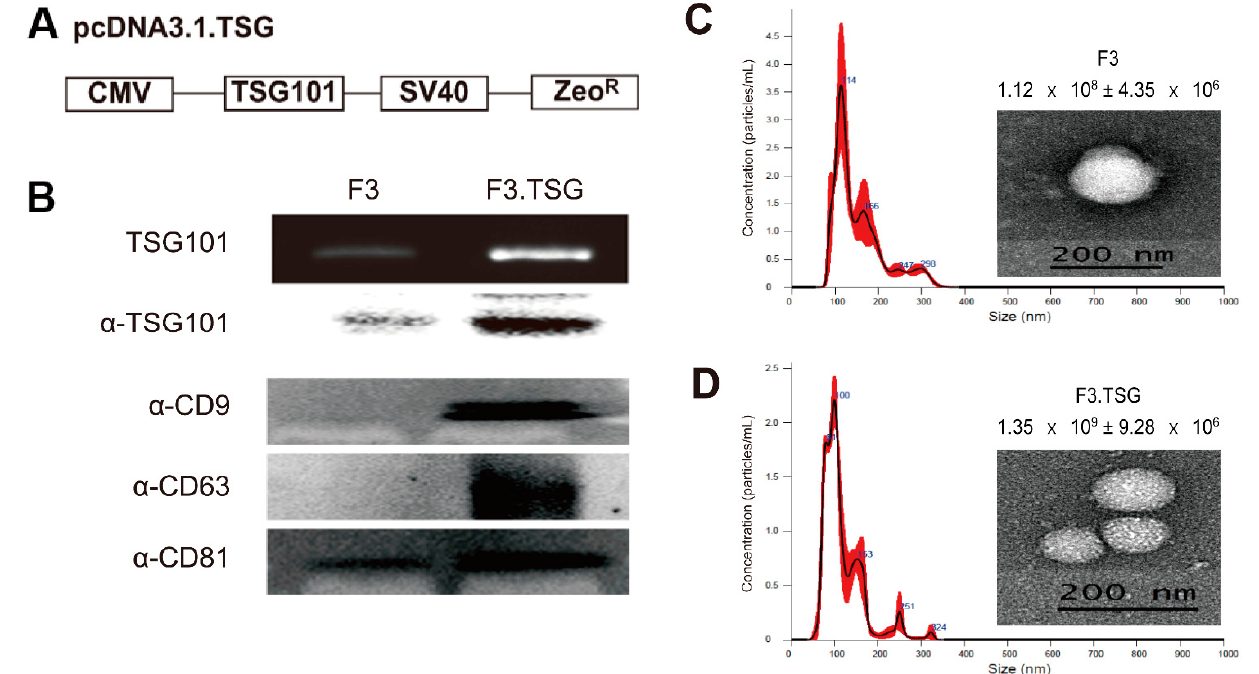
Figure 1. Establishment of F3.TSG. (A) Construct of pcDNA3.1_TSG. (B) Expression of exosome marker (TSG101, CD9, CD63 and CD81) in F3 and F3.TSG by RT-PCR and western blotting. (C,D) Number of exosomes by nanoparticle tracking analysis in F3 (C) and F3.TSG cells (D). All samples were analyzed in triplicate.